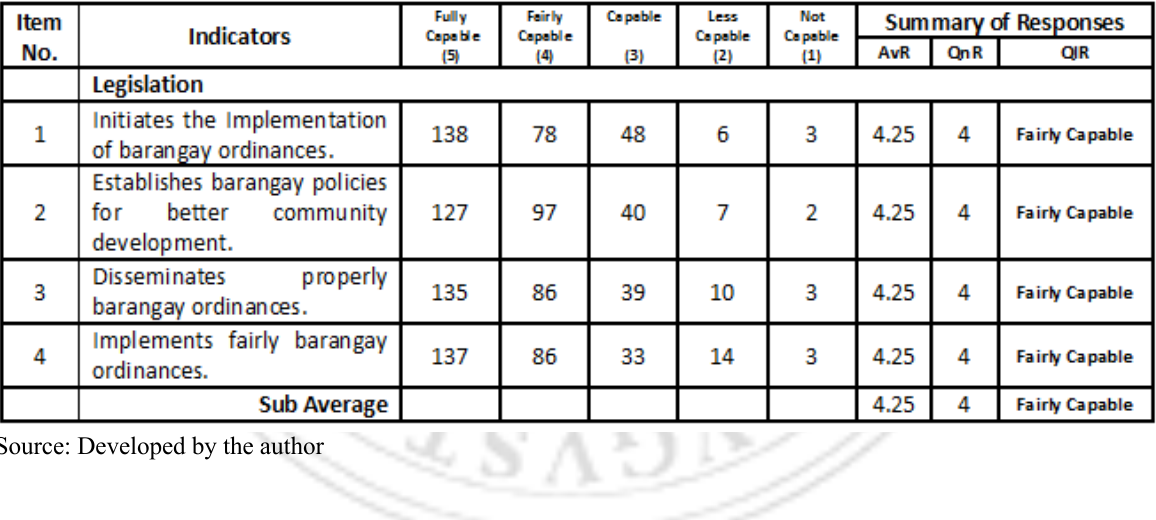
Table 3.1. The Perception of the Respondent-Barangay Officials in Northeast of Catanduanes regarding their